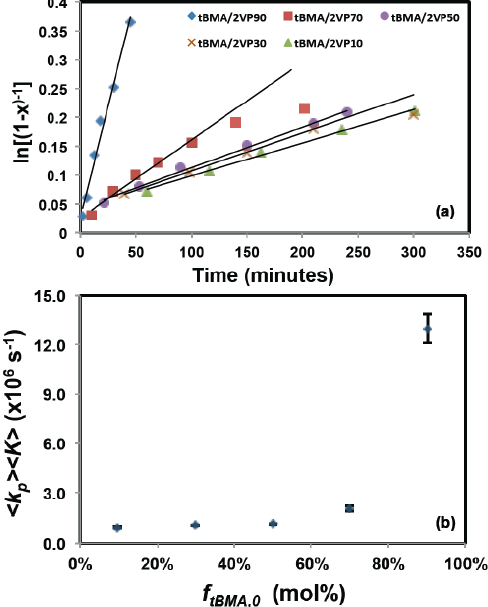
Figure 1. ( a ) Kinetic results (ln[(1 − x ) − 1 ] versus time) of the statistical copolymerization of tBMA with 2VP initiated by NHS-BlocBuilder ( x = monomer conversion). ( b ) Product of average propagation rate constant < k p >, and propagating radical concentration [P•], <k p > [P•] (slope of the kinetic plots in ( a )), versus feed composition with respect to t BMA ( f tBMA,0 ); error bars represent the standard deviation of the slopes from ( a ).